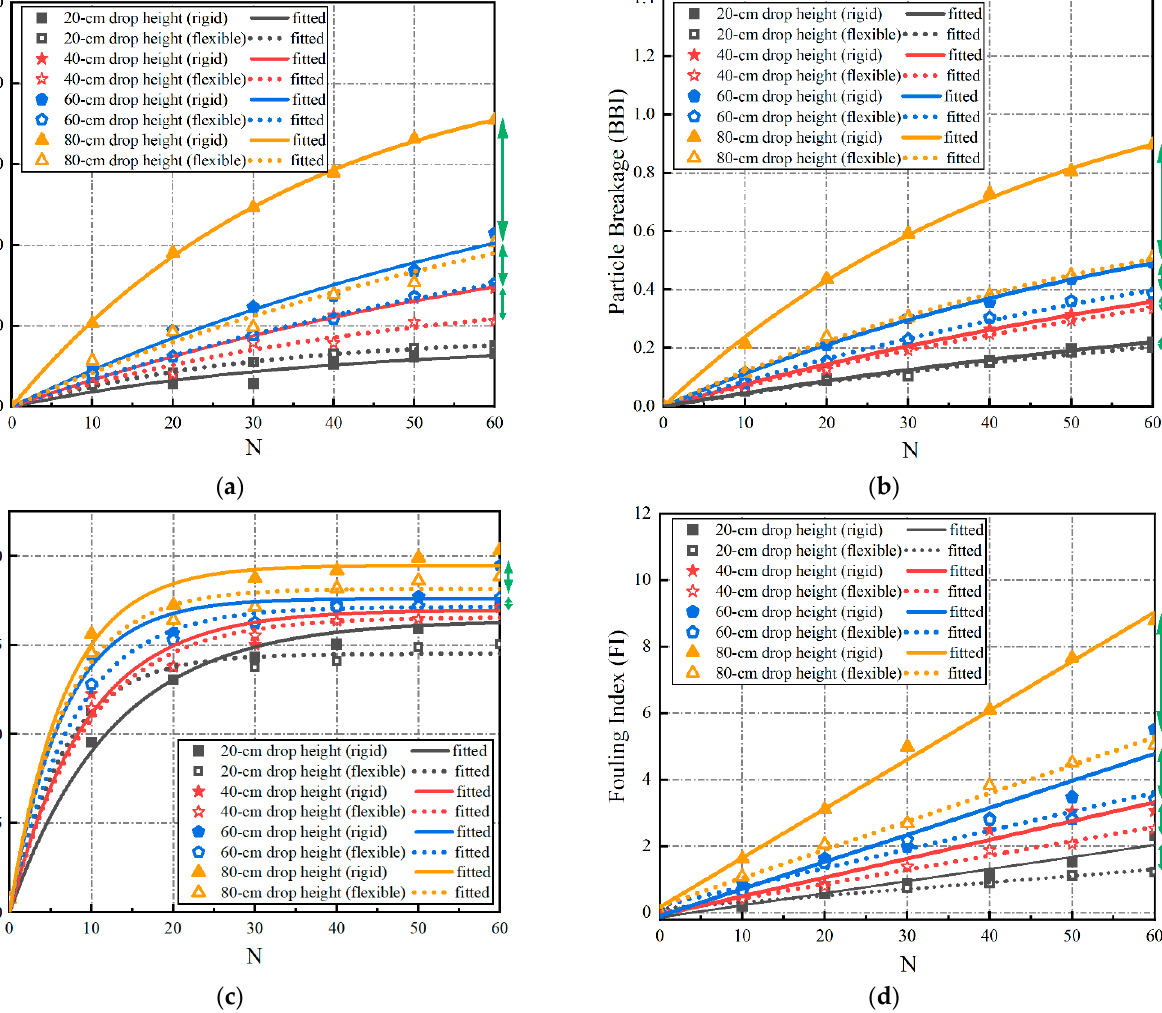
Figure 14. Evolution of four particle-breakage indices with the number of impact-load applications (N) for multiple-size ballasts under different combinations of under-ballast supports and drop heights: ( a ) 𝐵 (cid:3034) ; ( b ) BBI; ( c ) D; ( d ) modified FI. Table 4. The fitted coefficient values of Equations (7) and (9) for multiple-size ballasts under differ- ent combinations of under-ballast supports and drop heights.